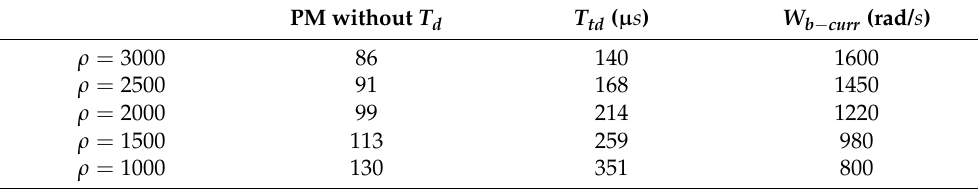
Table 2. Effect of the control parameter on PM and bandwidth of the current control